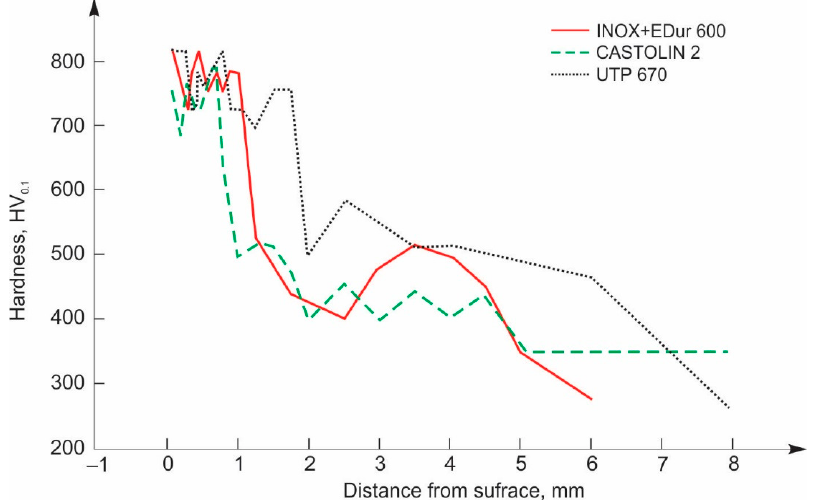
Figure 9. Microhardness distribution of samples regenerated by the hard filler metals.